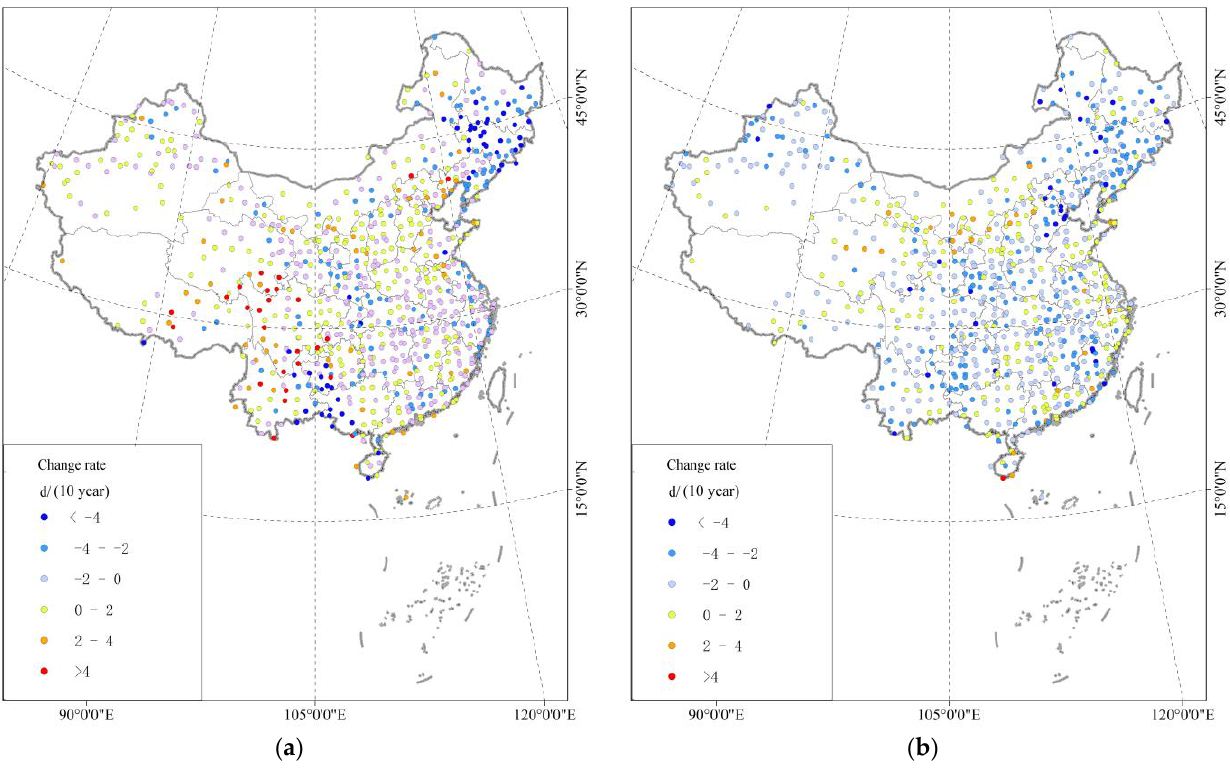
Figure 7. spatial distribution of CTXx and CTNn changes from 1966 to 2015 (+ appears later, - ap- Figure 7. Spatial distribution of CTXx and CTNn changes from 1966 to 2015. ( a ) CTXx. ( b ) pears earlier). ( a ) CTXx. ( b ) CTNn.